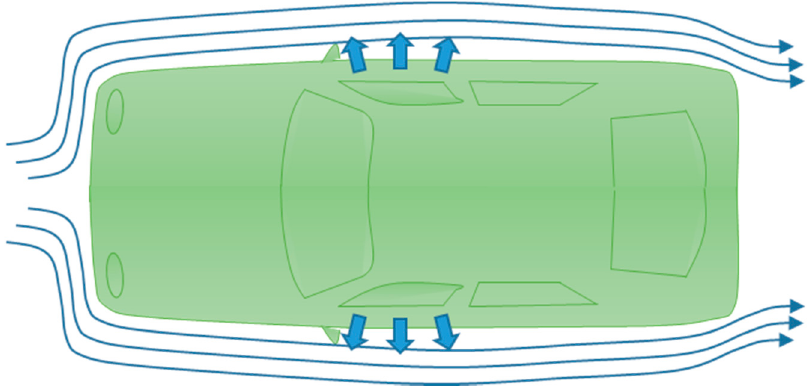
Figure 1. Qualitative representation of the phenomenon. Oriented lines represent external airflow, while bold arrows represent the actions of the internal static pressure field.